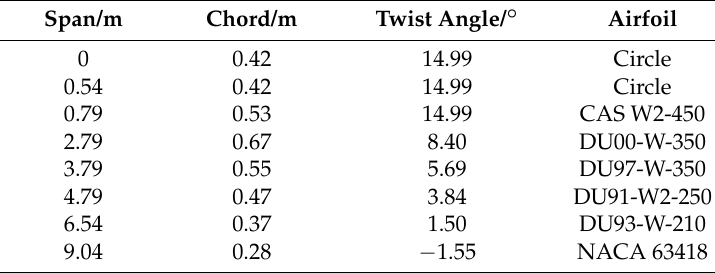
Table 3. Chord and twist angle distributions of blades.